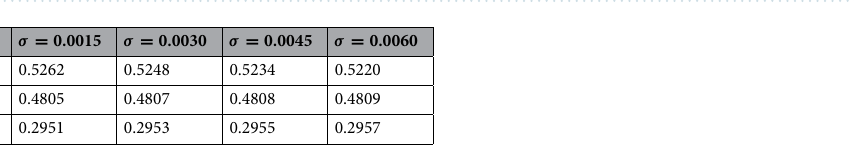
Table 8. Reliability under different perturbation intensities.